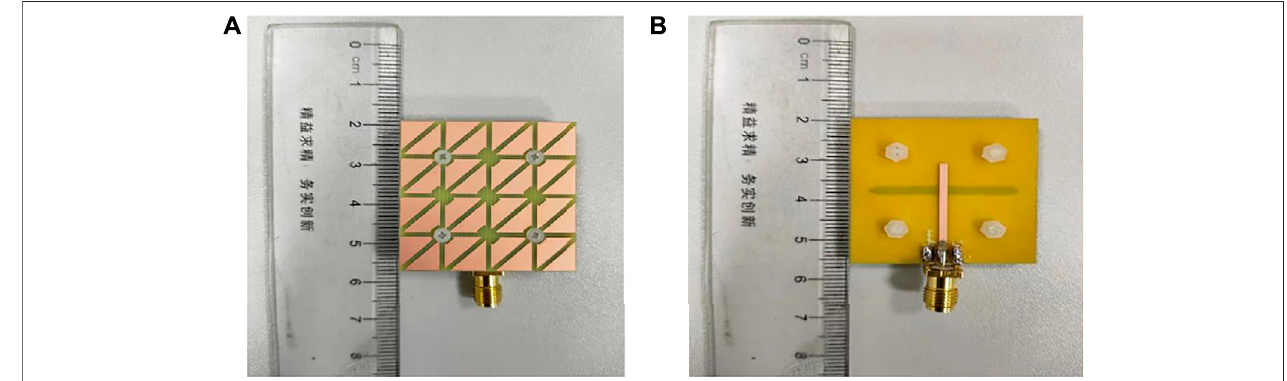
FIGURE 10 | Fabricated photos of metasurface antenna: (A) Top view; (B) Rear view.